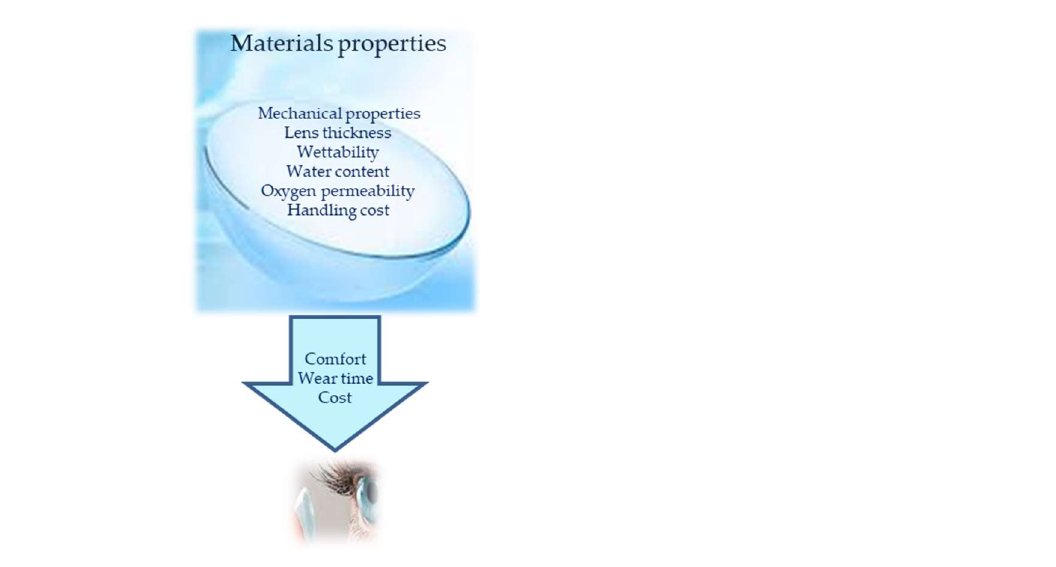
Figure 1. From the material point of view, contact lenses depend on several materials properties. Final contact lenses require a consideration of wear time, comfort and cost. These characteristics depend on material properties, manufacturing processes and final treatment. Table 1. Advantages and disadvantages of the most commonly used contact lens biomaterials.